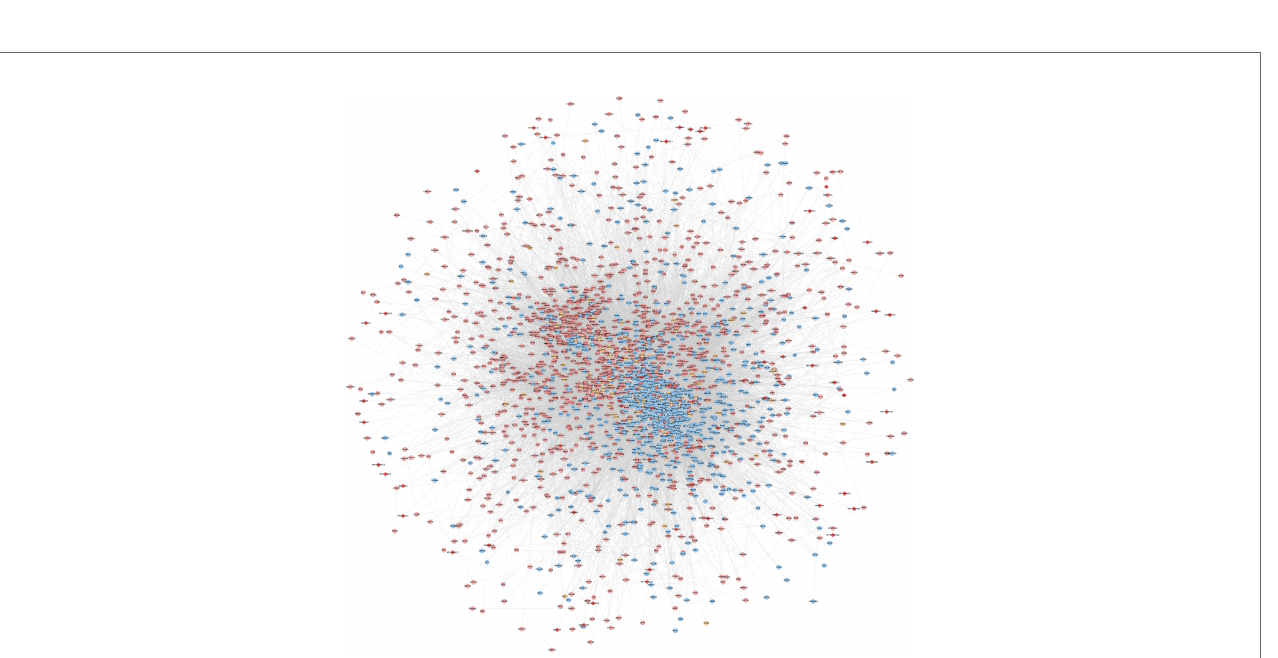
FIGURE 12 | LncRNA-mRNA co-expression network of the disease group before treatment/healthy control group (Red diamonds represent lncRNA. Blue, pink, and orange circles represent mRNA predicted by the lncRNA, mRNA detected by the experiment and mRNA that interacts with lncRNA,